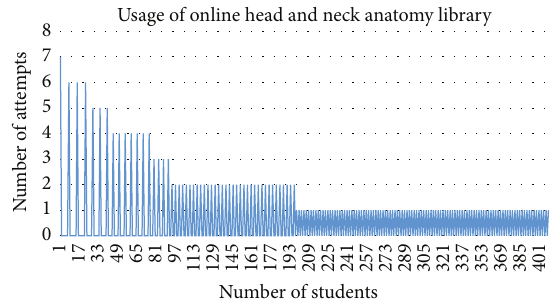
Figure 4: A summary of the students’ usage of the online head and neck anatomy library investigated in this study. The number of studentsisshownonthe 𝑥 -axisandthenumberofattemptsisshown on the 𝑦 -axis.